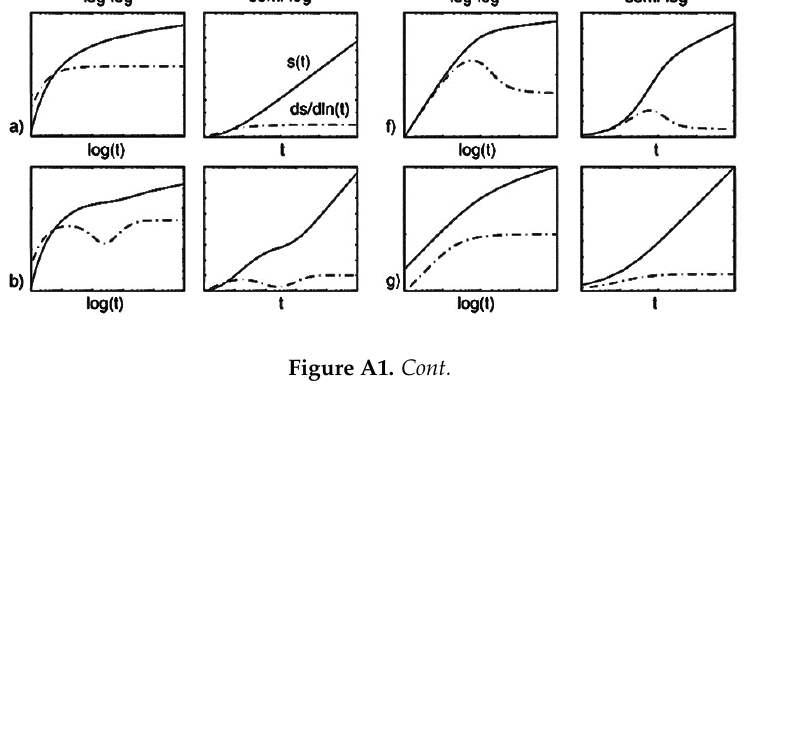
Figure A1. ( a ) Theis model: infinite two-dimensional confined aquifer; ( b ) double porosity or unconfined aquifer; ( c ) infinite linear no-flow boundary; ( d ) infinite linear constant head boundary; ( e ) leaky aquifer; ( f ) well-bore storage and skin effect; ( g ) infinite conductivity vertical fracture; ( h ) general radial flow—non-integer flow dimension smaller than 2; ( i ) general radial flow—noninteger flow dimension larger than 2; ( j ) combine effect of well bore storage and infinite linear constant head boundary. References 1.